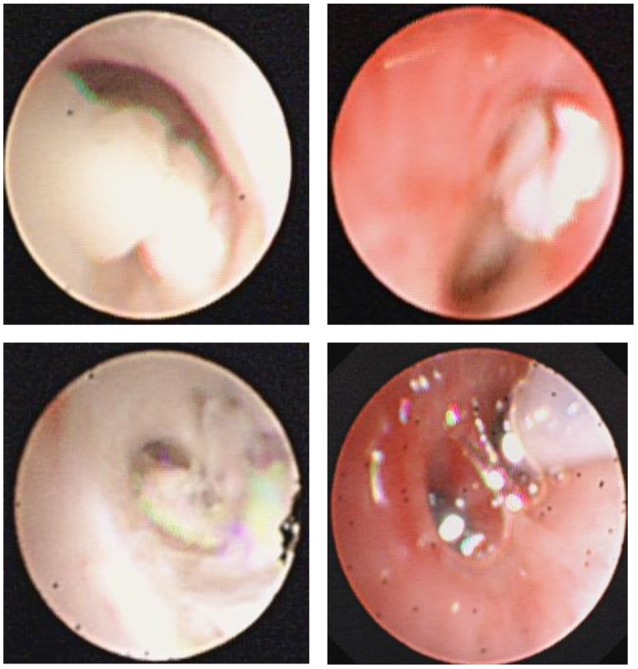
Fiberoptic bronchoscopy revealed mucous plug which suggested airway hypersecretion or airway obstruction in RMPP patients.